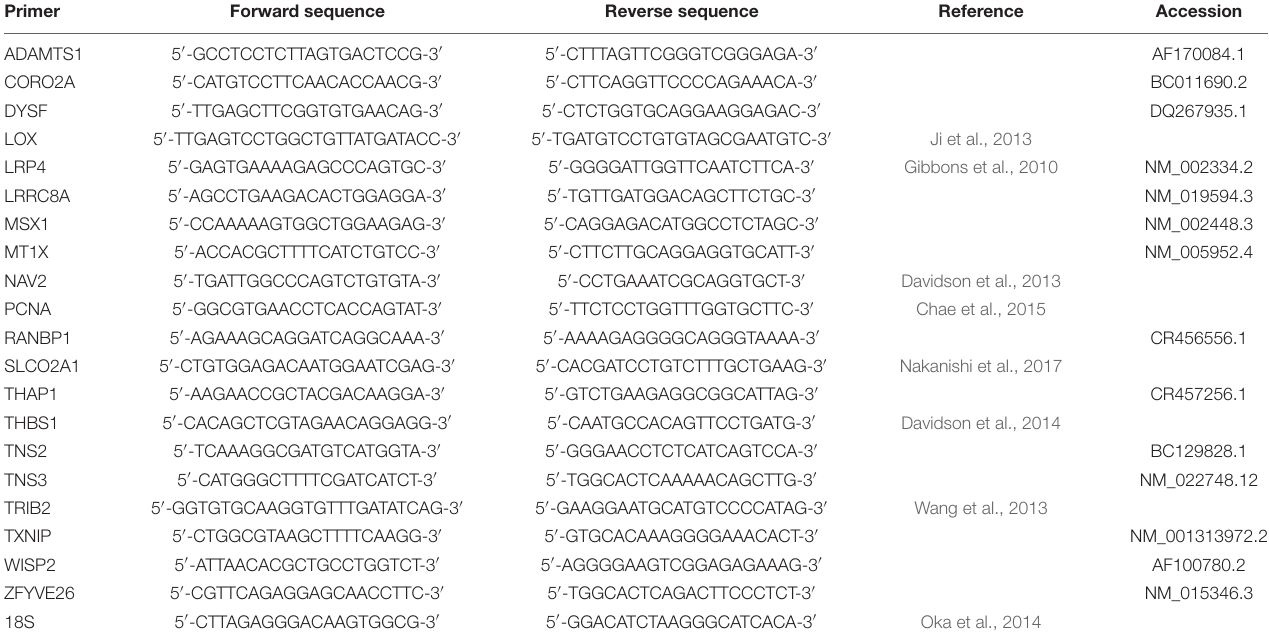
TABLE 3 | Primers used in